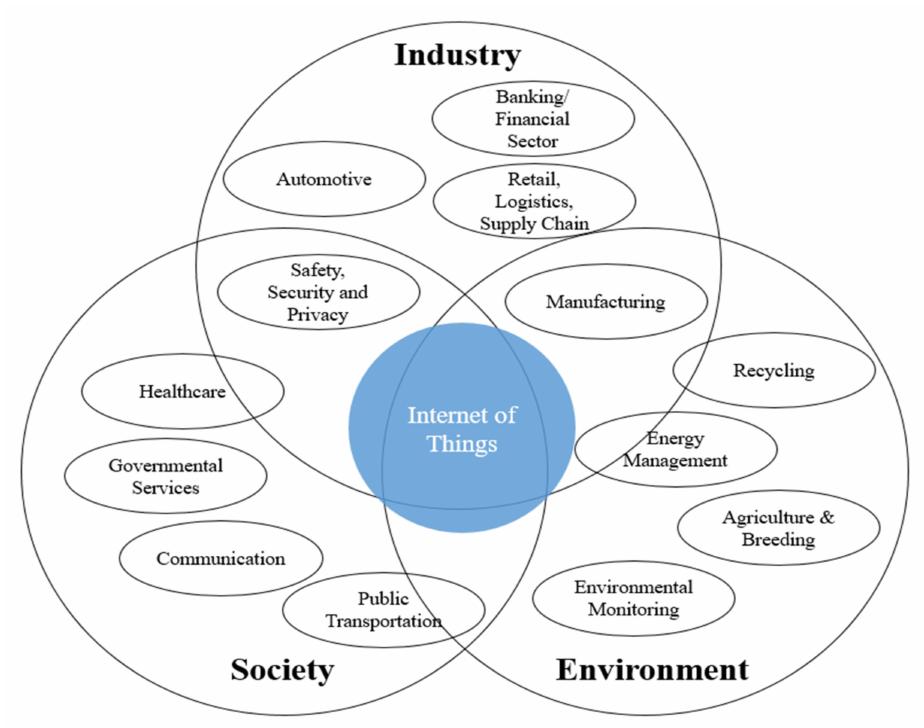
Figure 2. Application domains. Source: Based on Guillemin and Friess (2009)